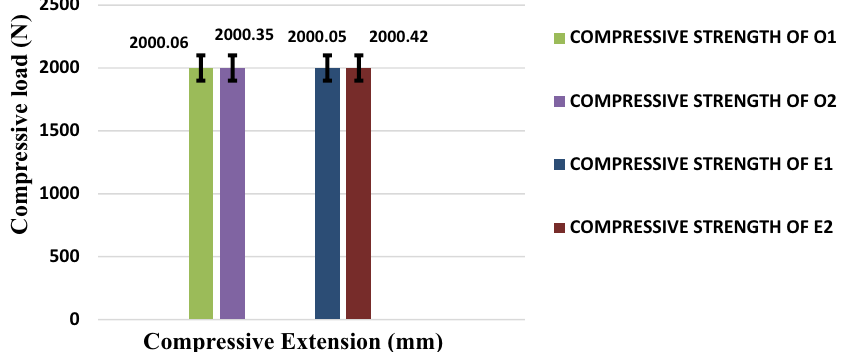
Figure 35: Comparison of compressive strength ( MPa ) of recycled EVA polymer composites with or without leather bu ffi ng dust.